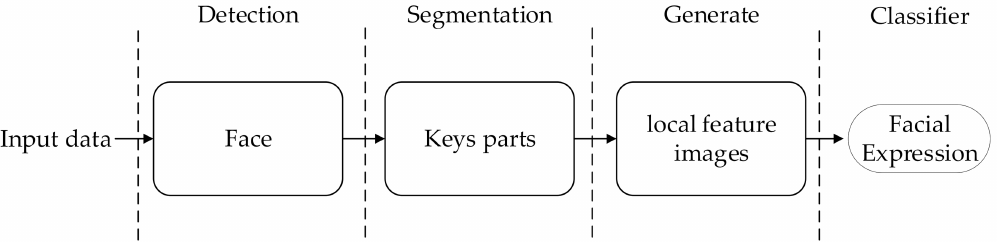
Figure 1. The algorithm flow chart proposed in this paper. The input video data obtain the face image through the face detection module. Then, the region of interest is selected to generate key parts feature image. Finally, the face image and the generated feature image are sent to the network for expression classification.